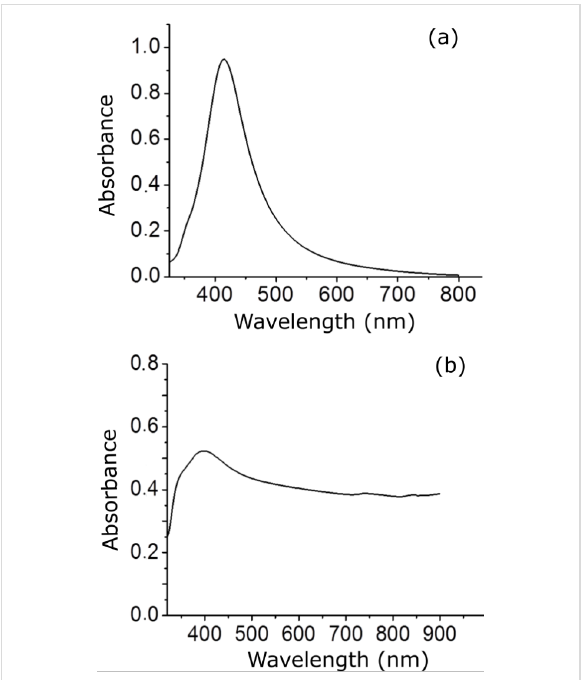
Figure 1: UV–vis absorption spectra of (a) silver nanoparticles with an absorption band at 415 nm and (b) solution of silver nanoparticles and potassium chloride. The absorption band of aggregated nanoparticles was shifted to near infrared